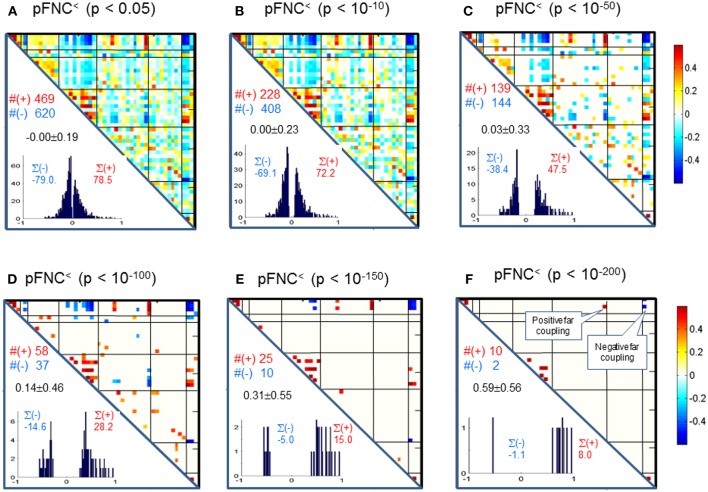
(A–F) Significant connections in group pFNC matrix under p-value thresholding with pthresh = {0.05, 10−10, 10−50, 10−100, 10−150, 10−200}. The numbers of positive and negative connections (denoted by #(+) and #(–) respectively), and sums of positive and negative connections (denoted by ∑(+) and ∑(–) respectively) were calculated from the survival entries in the pthresh-thresholded matrices (pFNC<).